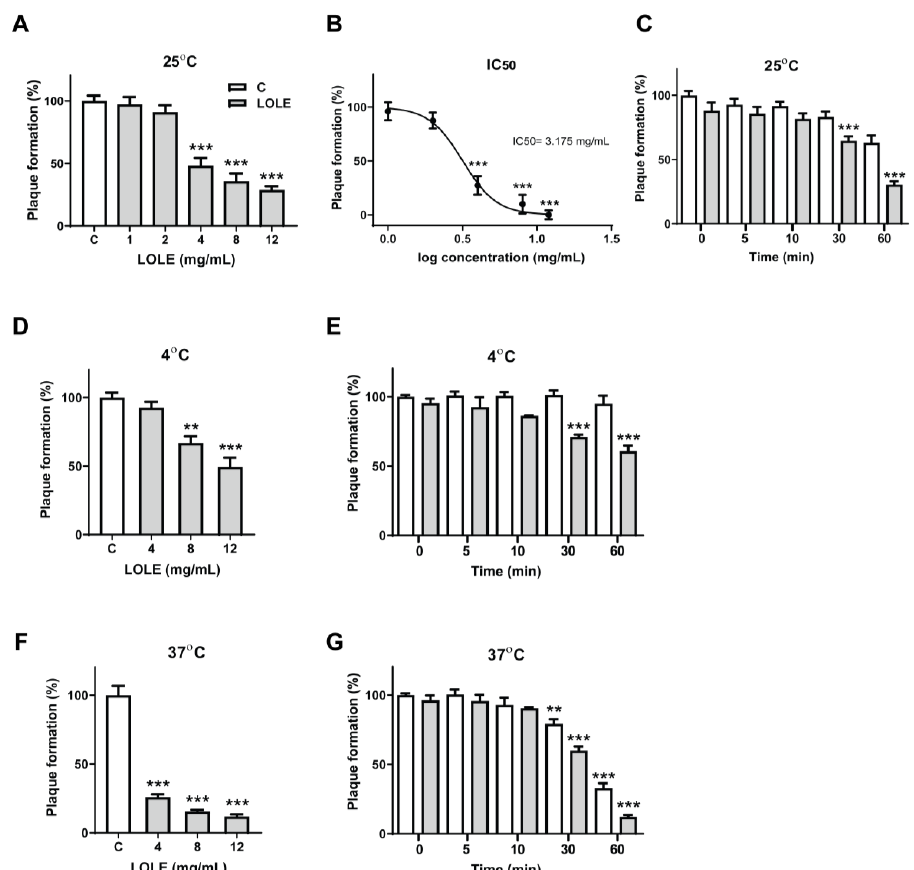
Figure 2. Temperature-, dose-, and time-response relationships between Lindera obtusiloba leaf extract (LOLE) exposure and murine norovirus (MNV-1) inactivation in RAW 264.7 cells. MNV-1 virus particles were pretreated with LOLE solutions of 1, 2, 4, 8, and 12 mg / mL for 1 h at 25 ◦ C before infecting RAW 264.7 cells. Dimethyl sulfoxide (DMSO) was used as a control and virus titer was measured by plaque assay. ( A , B ) E ff ect of LOLE on plaque formation (%) at various concentrations. ( C ) MNV-1 virus particles were pretreated for 0, 5, 10, 30 and 60 min with LOLE (12 mg / mL) at 25 ◦ C. ( D , F ) For temperature-dependent experiments, MNV-1 virus particles were pretreated with LOLE solutions of 4, 8, and 12 mg / mL for 1 h at 4 ◦ C and 37 ◦ C. For the time- and temperature-dependent experiments, virus particles were pretreated for 0, 5, 10, 30 and 60 min with LOLE (12 mg / mL) at 4 ◦ C and 37 ◦ C ( E , G ). The mean diameter of the plaques was 1 mm, and visible plaques were counted 72 h after infection (triplicate determinations). The white bars represent the control groups, whereas the gray bars represent the intervention groups. Results are expressed as the percentage of neutralized virus compared to control (mean ± SEM; n = 3). ** p < 0.01, *** p < 0.001 compared to